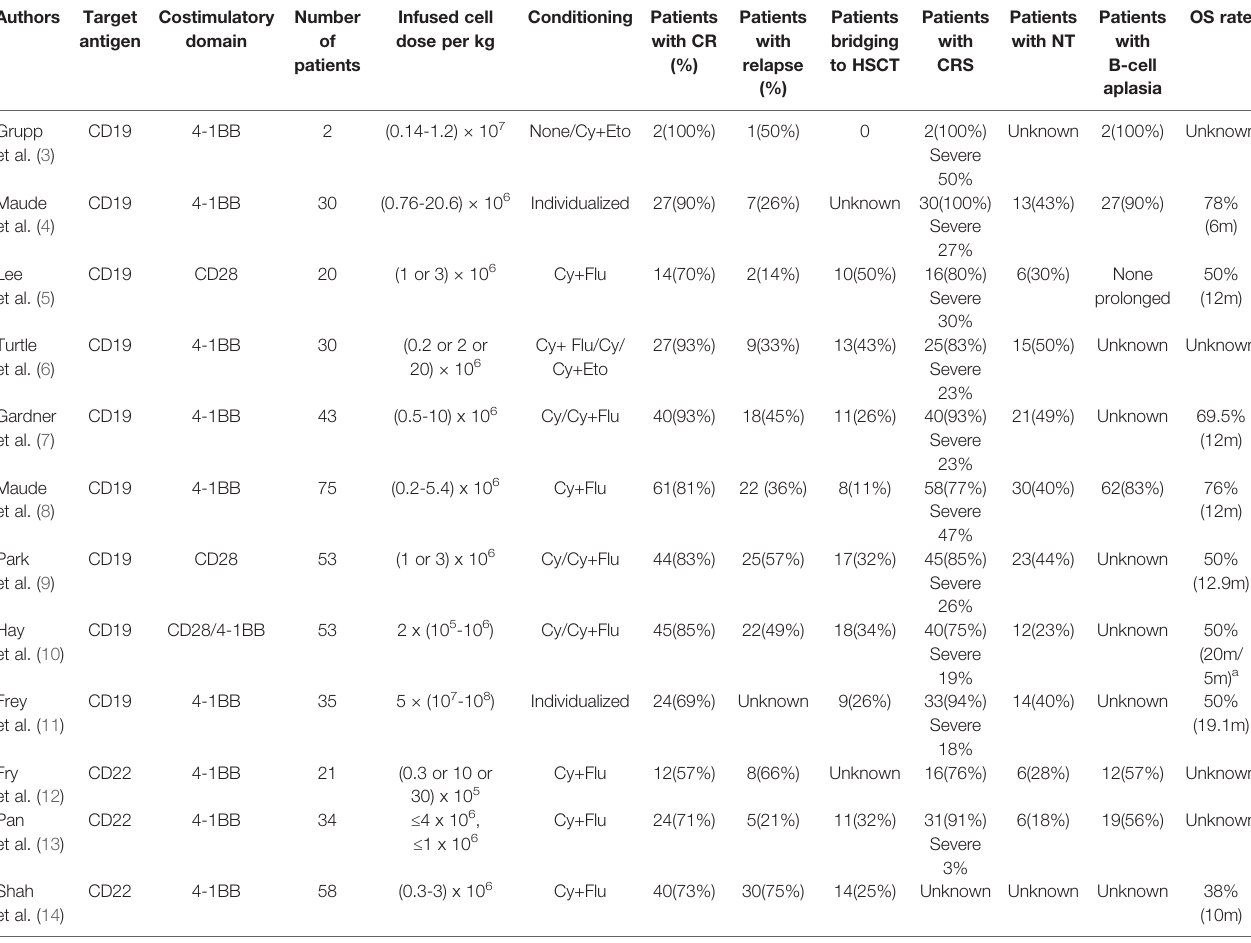
TABLE 1 | Selected published clinical trials of CAR T-cell therapy. Authors Target Costimulatory antigen